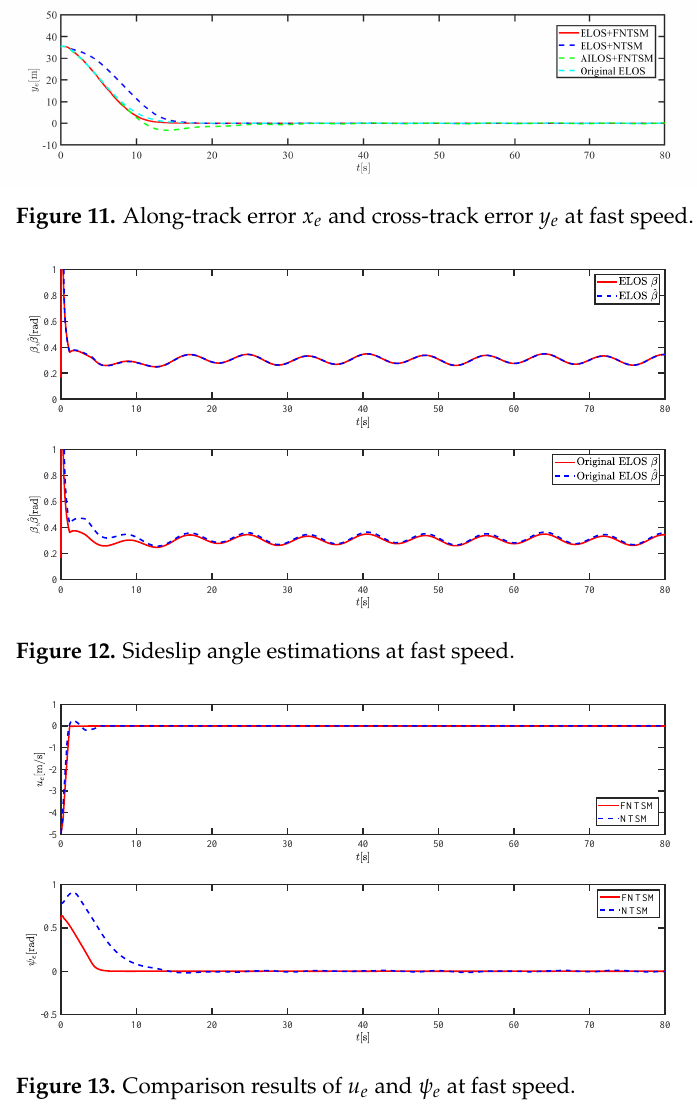
Figure 13. Comparison results of u e and ψ e at fast